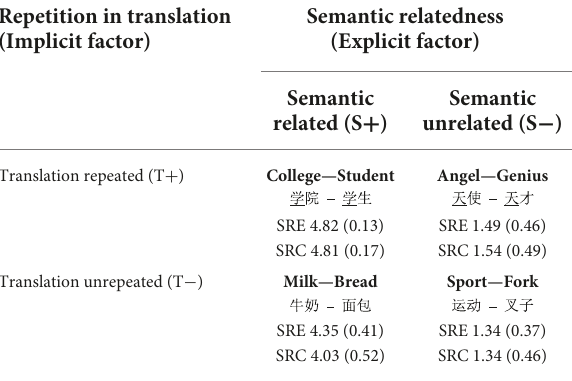
TABLE 1 Conditions (semantic relatedness and repetition in translation of the word pair) in the task of semantic relatedness